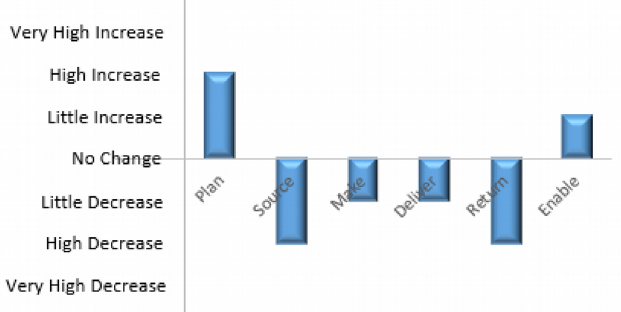
Figure 5. Performance measurement considerations by process during COVID-19 pandemic